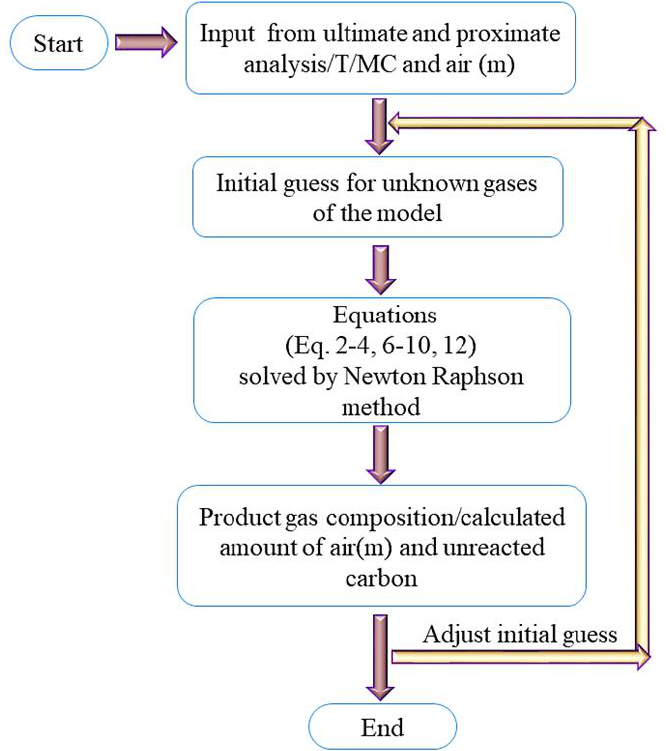
Figure 1. Model algorithm.